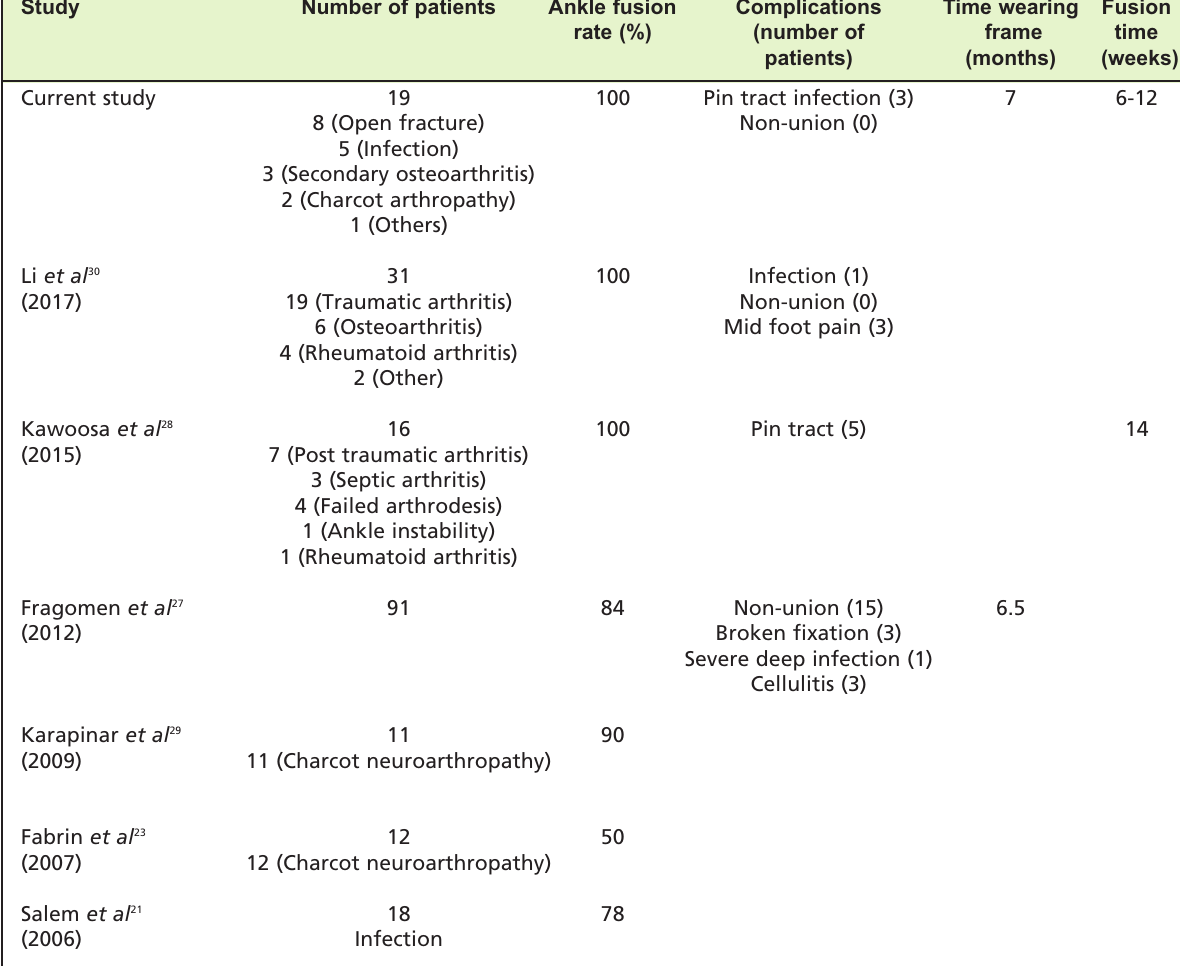
frame and fusion time